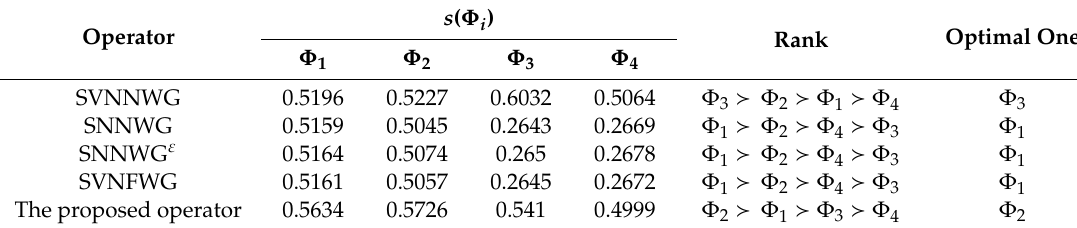
Table 3. Comparison results.